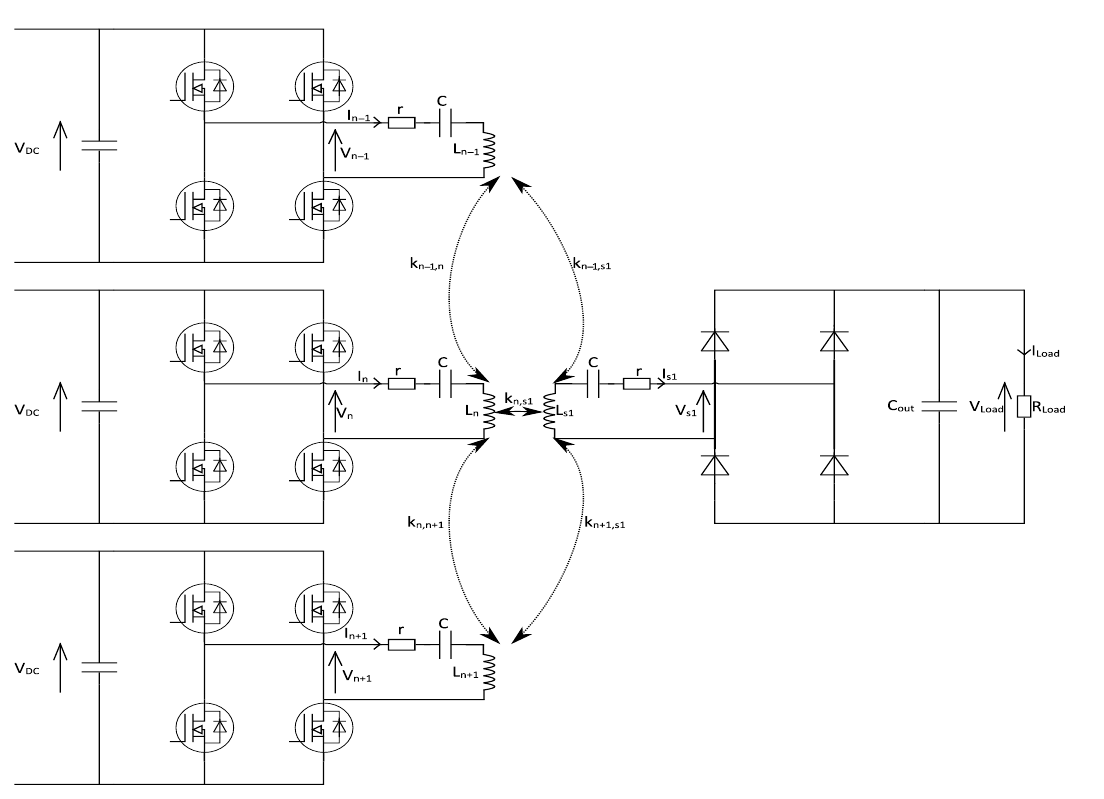
Figure 2. System ’ s equivalent model with three transmitters and one receiver. Figure 2. System’s equivalent model with three transmitters and one receiver.